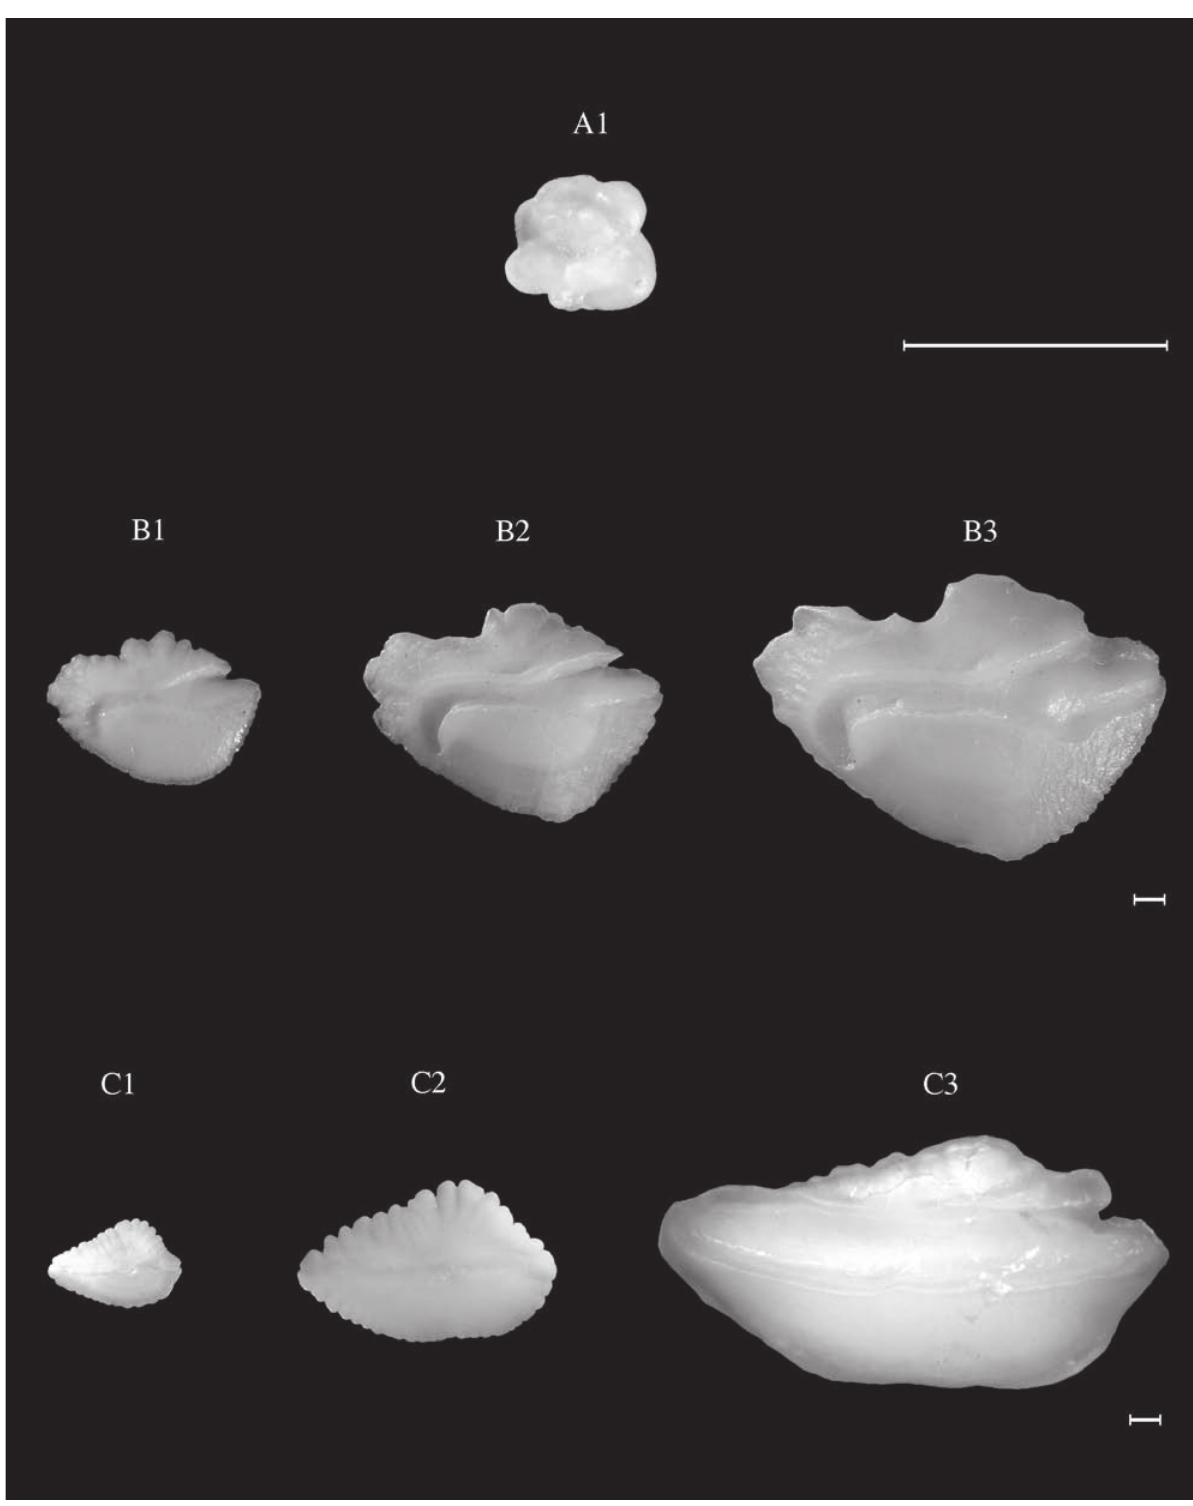
Fig. 24. – Trachipterus trachipterus (WM). TL: A1, 30.0 cm. Polymixia nobilis (CEA). TL: B1, 17.5 cm; B2, 28.2 cm; B3, 41.7 cm. Caelorinchus caelorhincus . PL: C1, 1.5 cm (WM); C2, 6.1 cm (NEA); C3, 11.5 cm (WM). Scale bar = 1